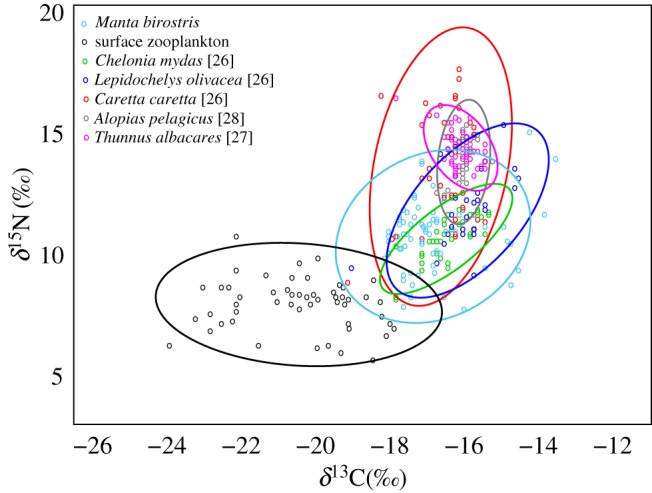
Bi-plot of δ15N and δ13C values with Bayesian ellipses overlaid for co-occurring organisms from the eastern equatorial Pacific Ocean.